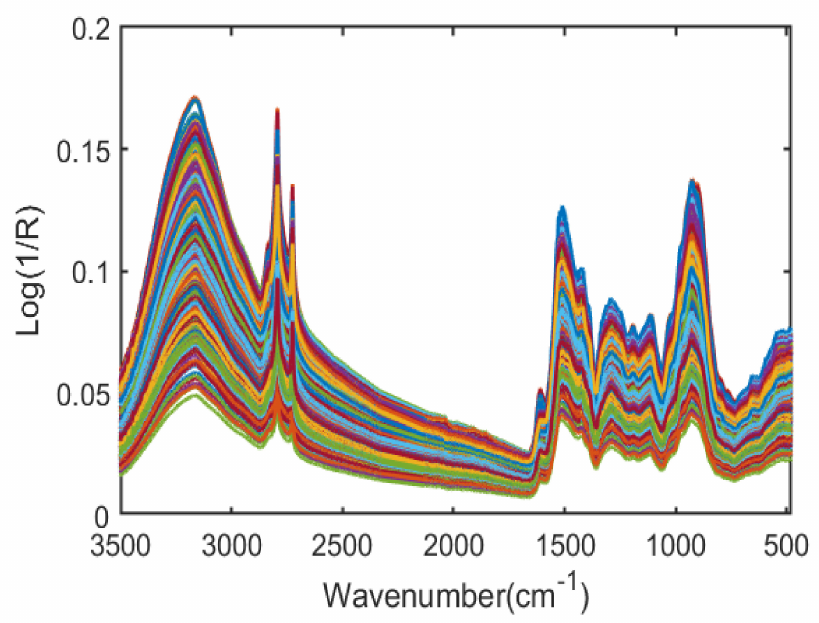
Figure 1. FT-IR raw spectra of moringa powder samples. Figure 2a represents SNV preprocessed spectra of moringa powder samples under 14 different concentrations. All the 14 different concentrations of moringa samples were divided into three categories, which were <2.6 mg/g, 2.6–3.4 mg/g, and >3.4